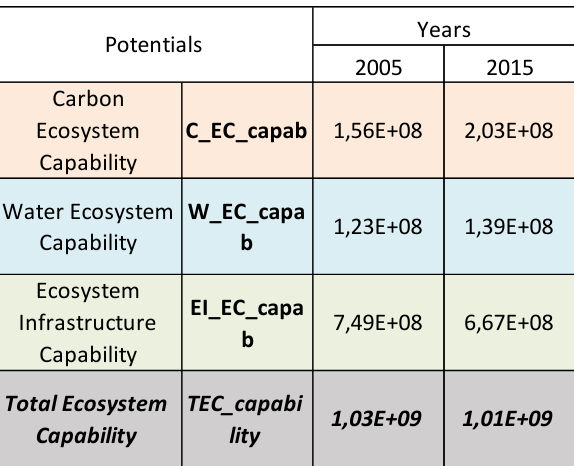
Figure 12 : Total ecosystem capability (TEC) of Guinea for Figure 10. Net Primary Productivity (NPP), in tonnes of carbon per ha, by UPSE – data in 2015